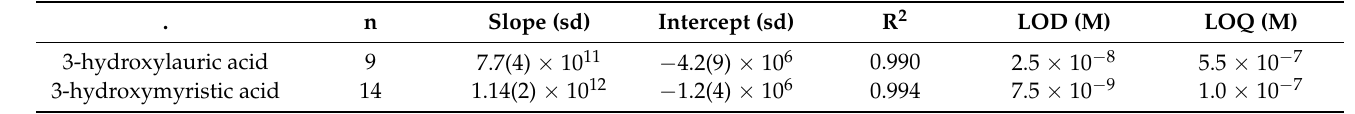
Table 1. Linear fit for calibration of 3-hydroxylauric acid and 3-hydroxymyristic acid derivatives formed with